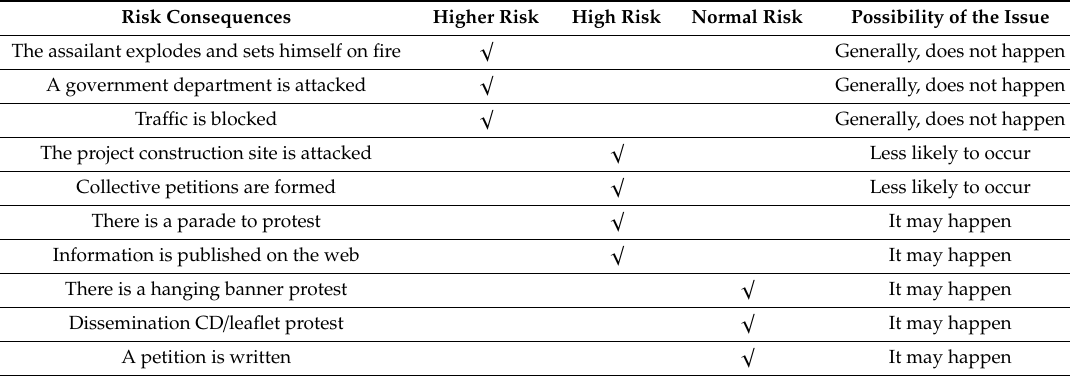
Table 5. Risk event and risk consequence assessment form.